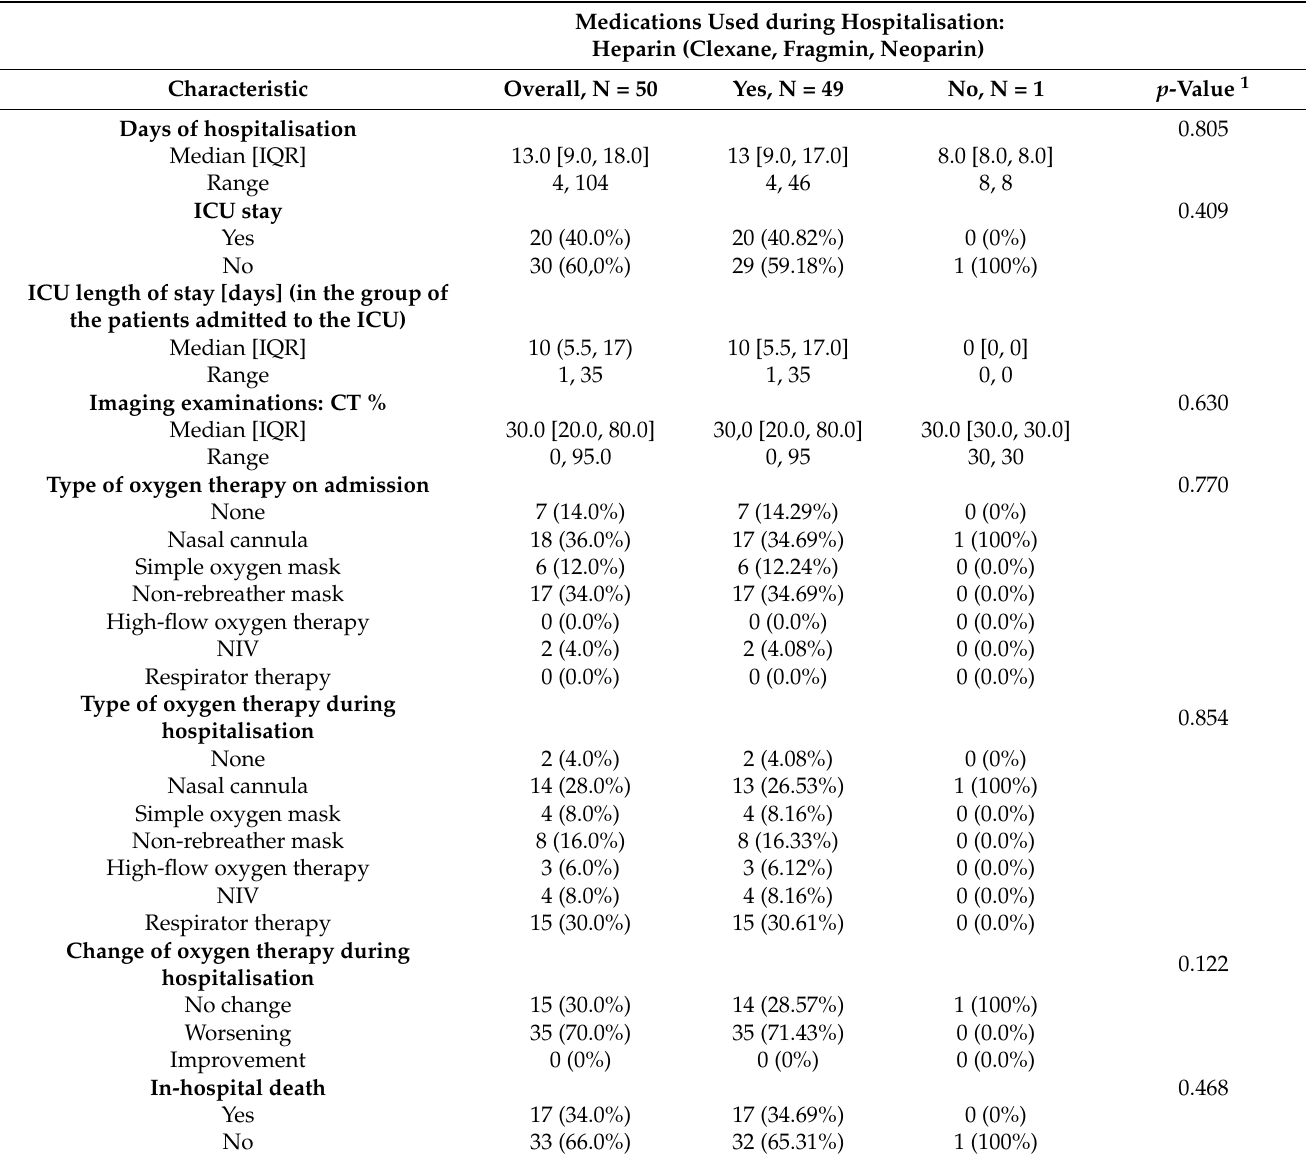
Table 8. Severity of COVID-19 vs. heparin medication, comparison between groups. Medications Used during